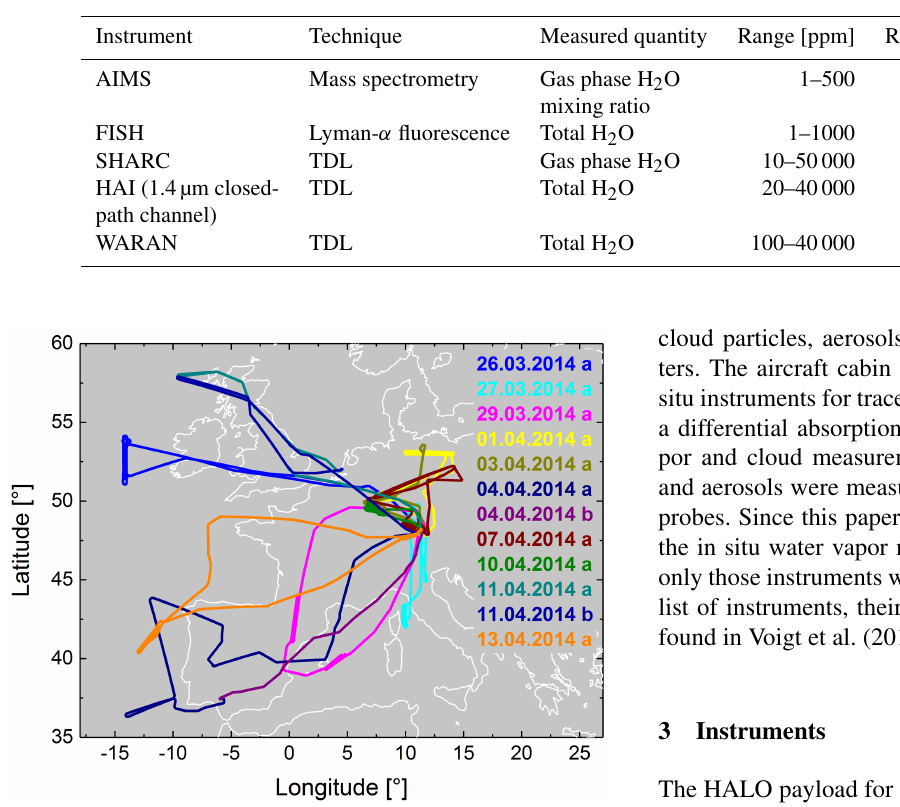
Table 1. Measurement technique, range and uncertainty of the different instruments. Resolution values in brackets are time resolutions used for this intercomparison.